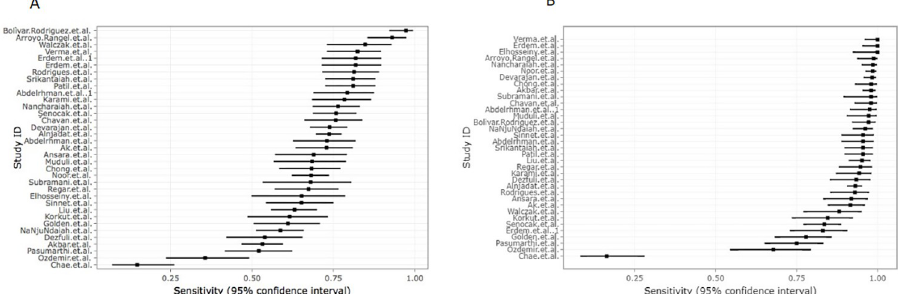
Fig 2. Plots of individual values of sensitivity for the Alvarado (A) and RIPASA (B) scores.